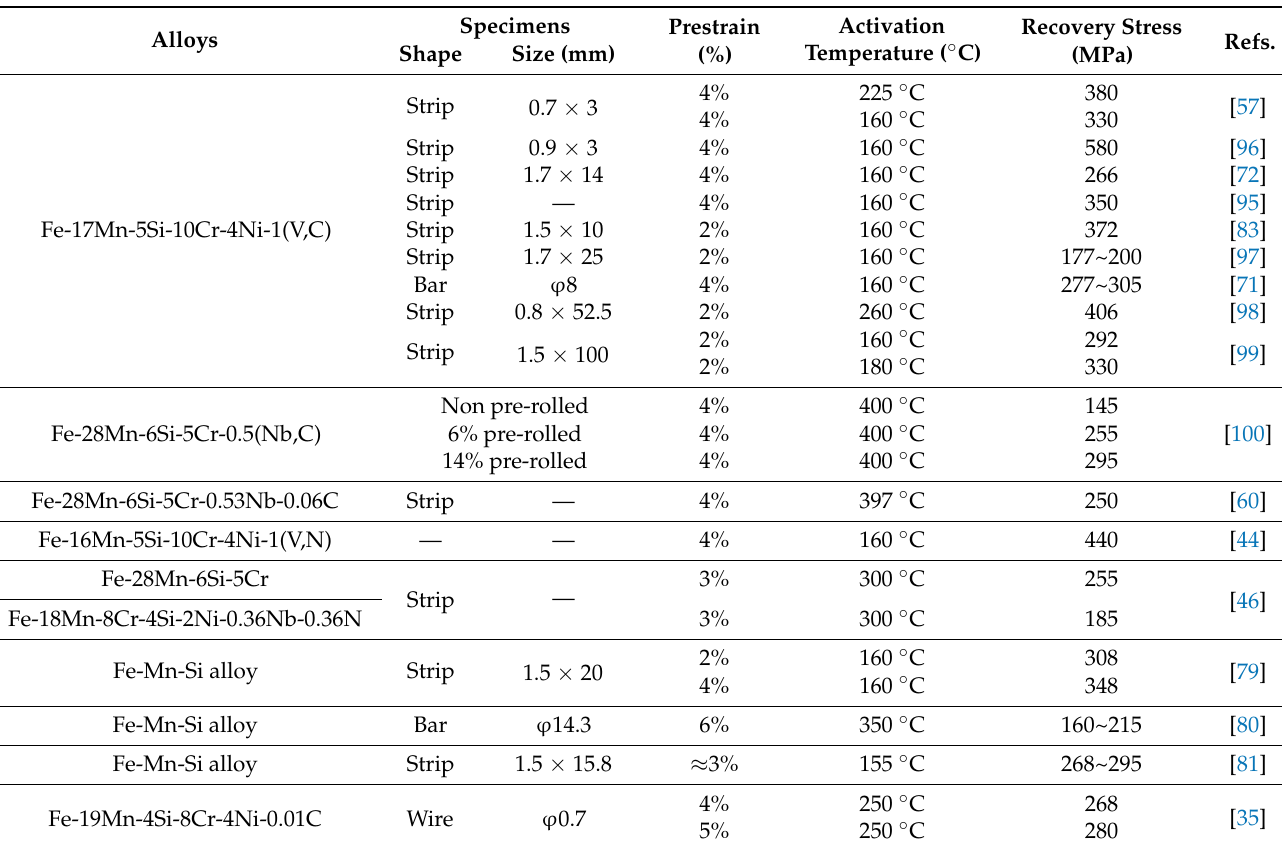
Table 5. Recovery stresses of Fe-SMA under different activation combinations.